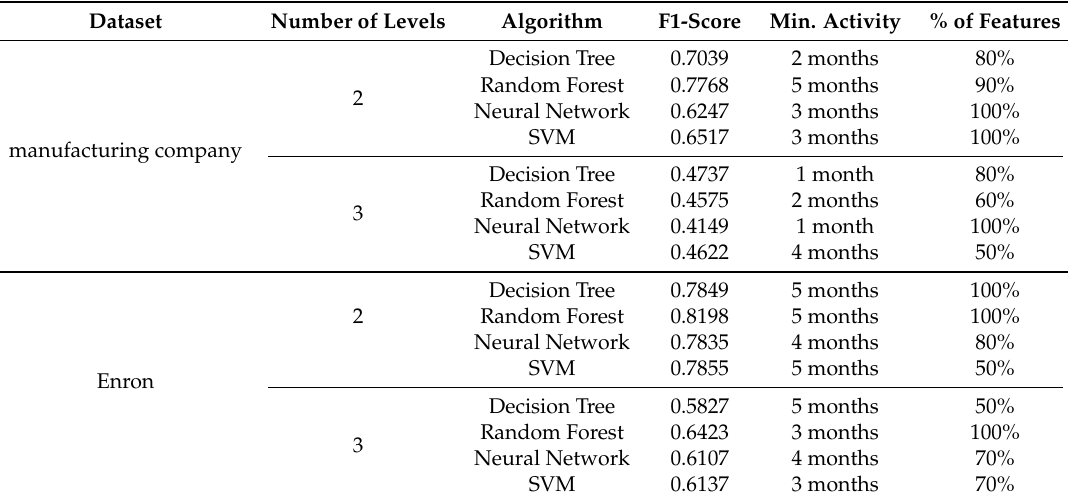
Table 4. The best results obtained by supervised